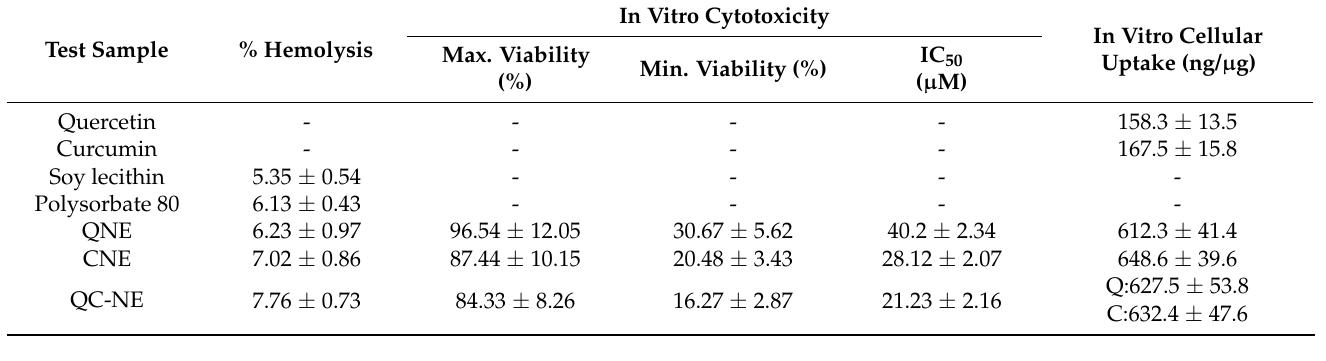
Table 2. Biological evaluation of various samples meant for intravenous administration.